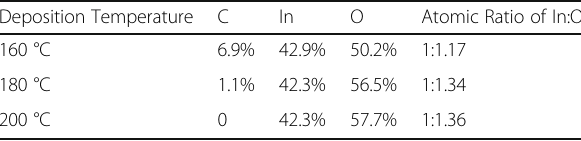
Table 1 The Elemental Percentages of In 2 O 3 Films Deposited at Different Temperatures Deposition Temperature